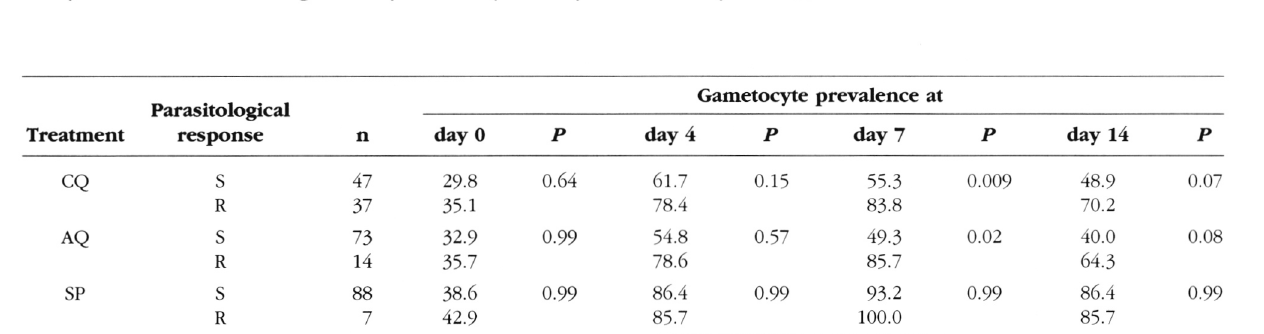
Table II. - P. falciparum gametocyte prevalence (%), according to treatments (CQ = chloroquine, AQ = amodiaquine, SP = sulfadoxine + pyrimethamine) and to parasitological responses (S = sensitive, R = resistant). The P values were obtained by the Fisher’s exact test.